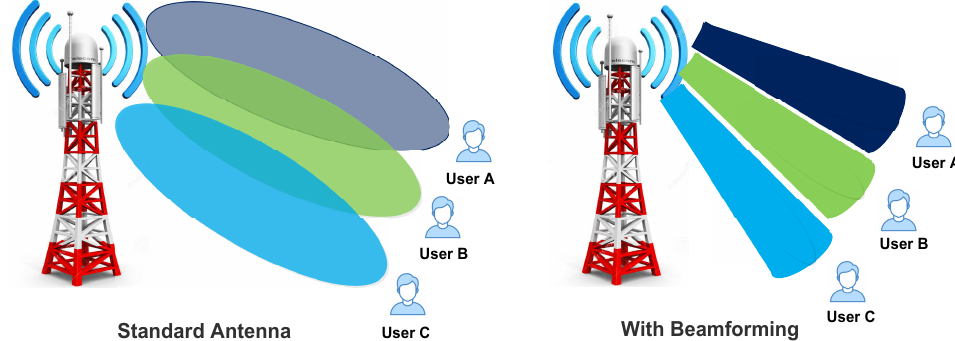
Figure 8. Pictorial Representation of communication with and without using beamforming.